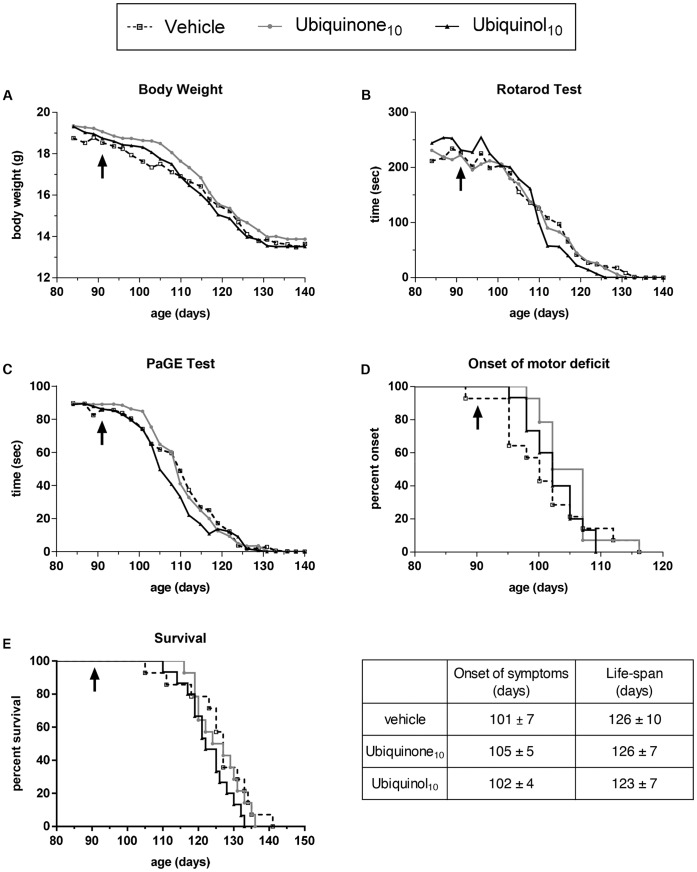
Ubiquinol10 chronic treatment has no effect on disease course in SOD1G93A mice.Effect of oral treatment with 800 mg/kg/day ubiquinone10, ubiquinol10 or vehicle, on motor dysfunction and disease progression of 129Sv SOD1G93A mice (n = 15 mice per group). Treatment started at the age of 91 days (arrows) until the sacrifice (at the end-stage of the disease, when mice were unable to right themselves within 10 seconds after being placed on both sides). Treatment with ubiquinone10 or ubiquinol10 had no significant effects on body weight (A), on the latency of rotarod (B) and PaGE test (C) (Two-way ANOVA), or on disease onset (D) and survival length (E). Each point represents the mean; for sake of clarity standard deviations are not indicated but they were always less than 15% of the value. Table reports the mean and standard deviations of symptoms onset and life-span for each group.